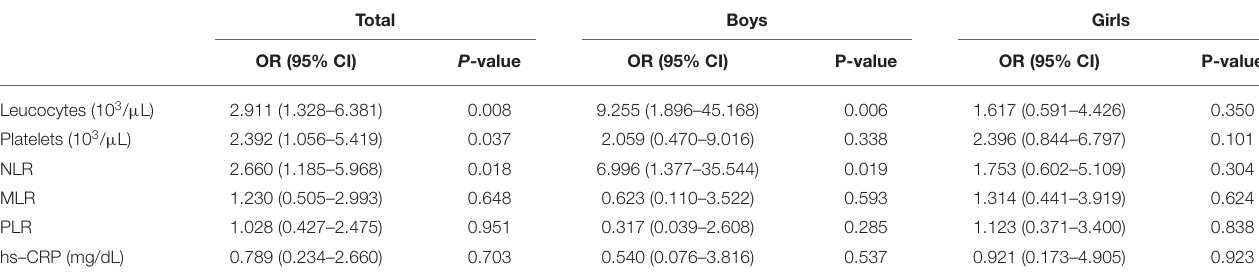
TABLE 3 | Association between high inflammatory indicators ( ≥ 75th of the total population) and the presence of IR in overweight/obese